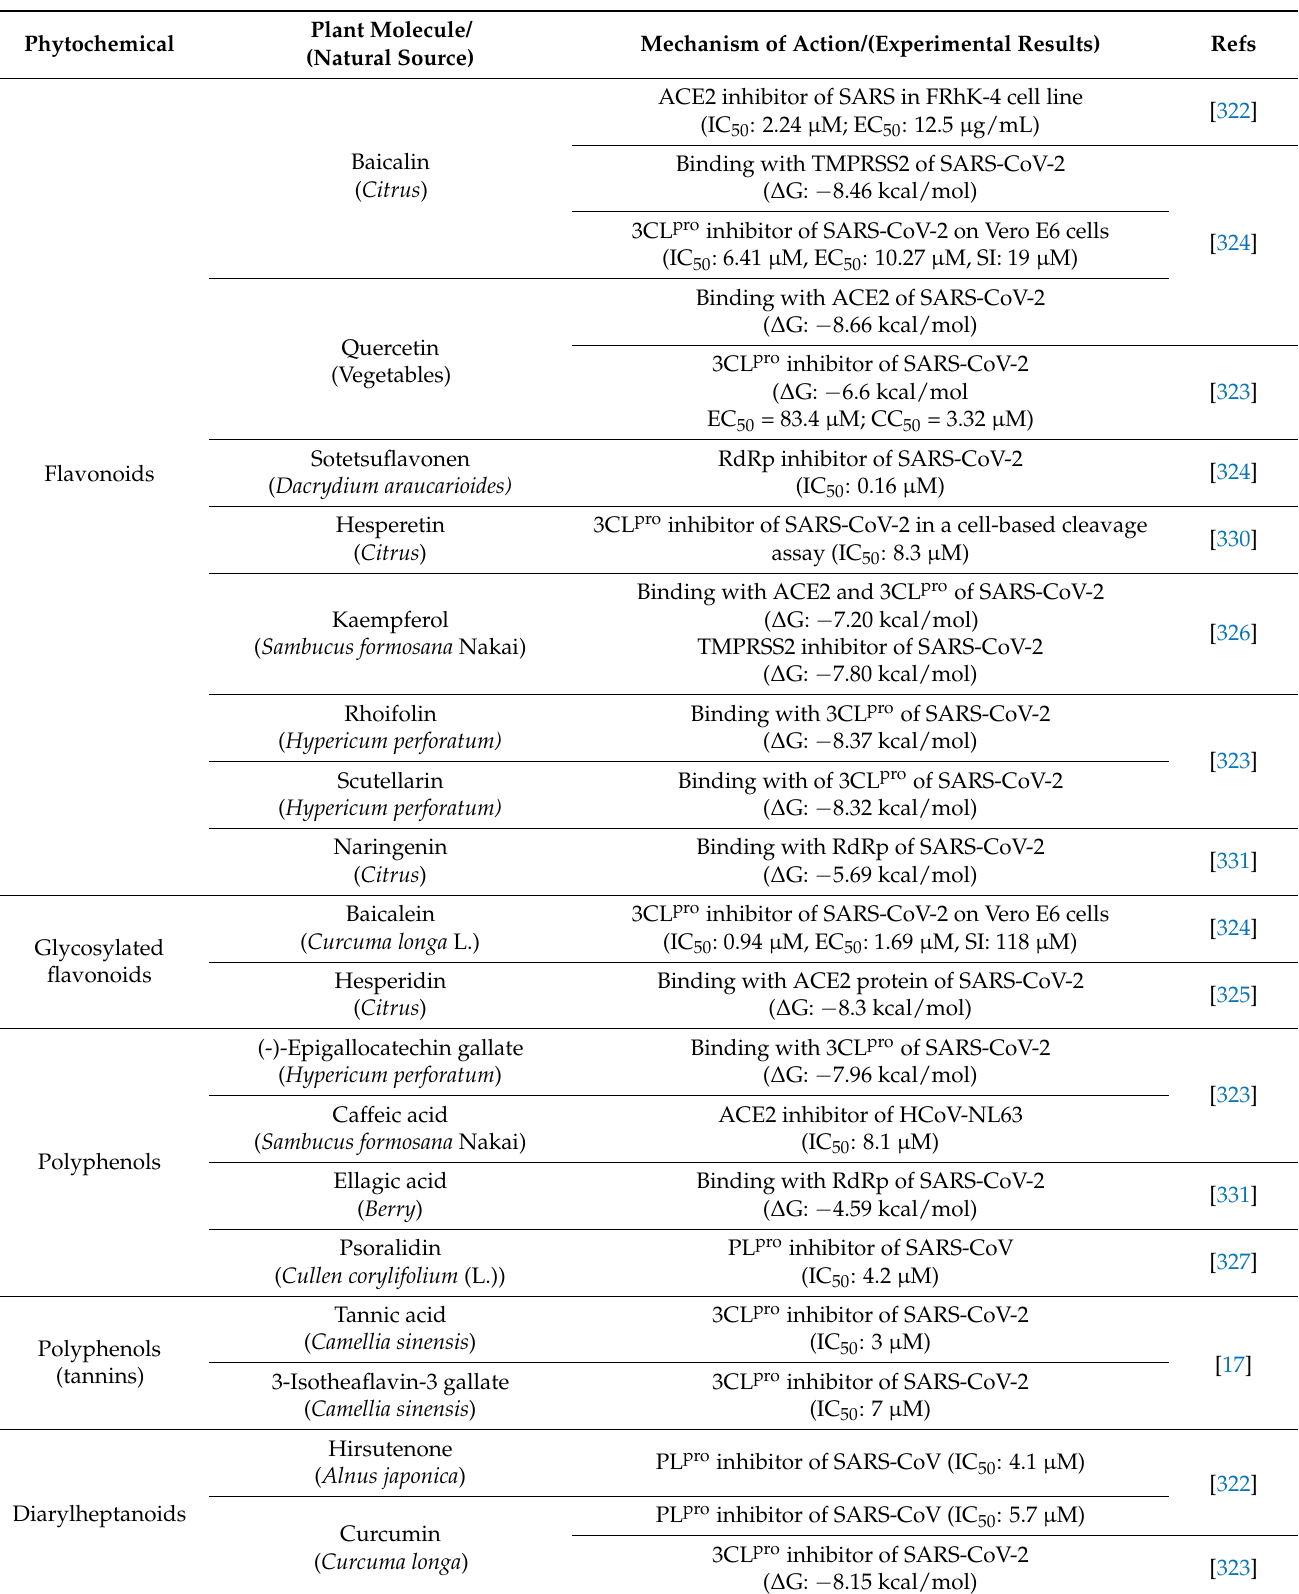
Table 2. Potential natural products against